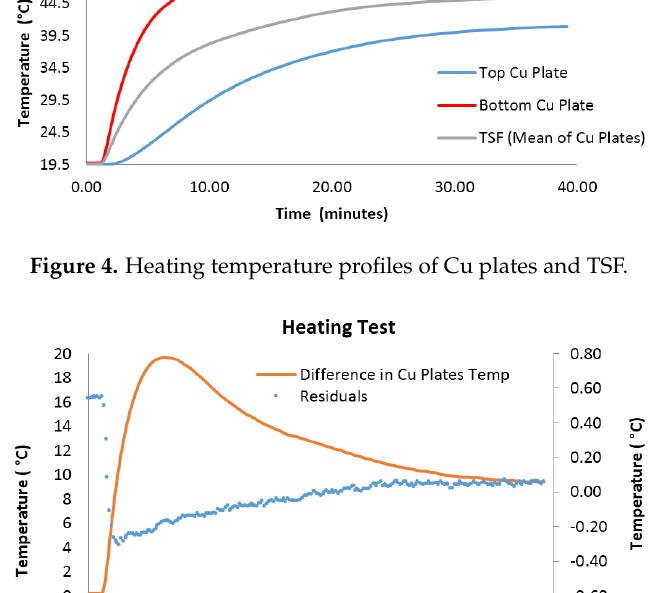
Figure 5. Profile of temperature difference of Cu plates and temperature residuals of fitted curve (heating test, with respect to time).